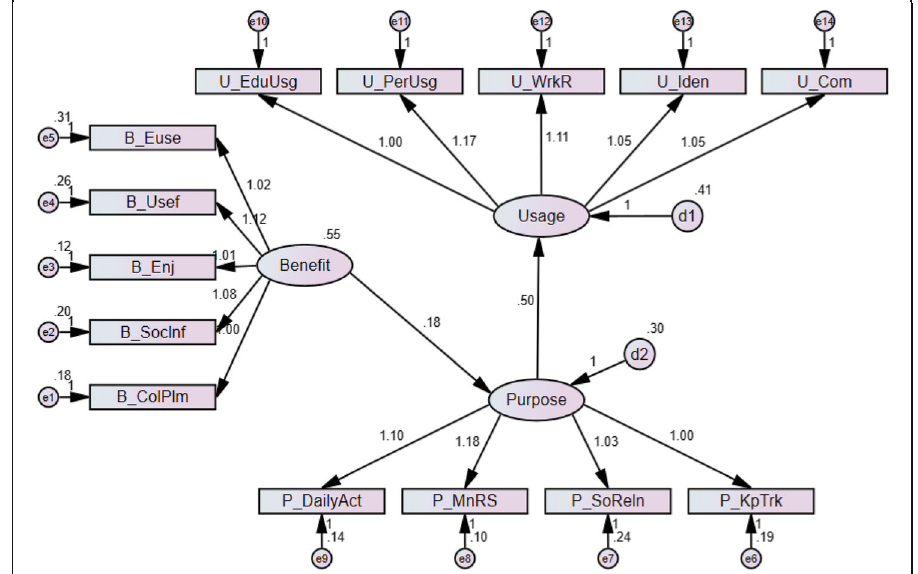
Fig. 2 The result of proposed research model (standardized